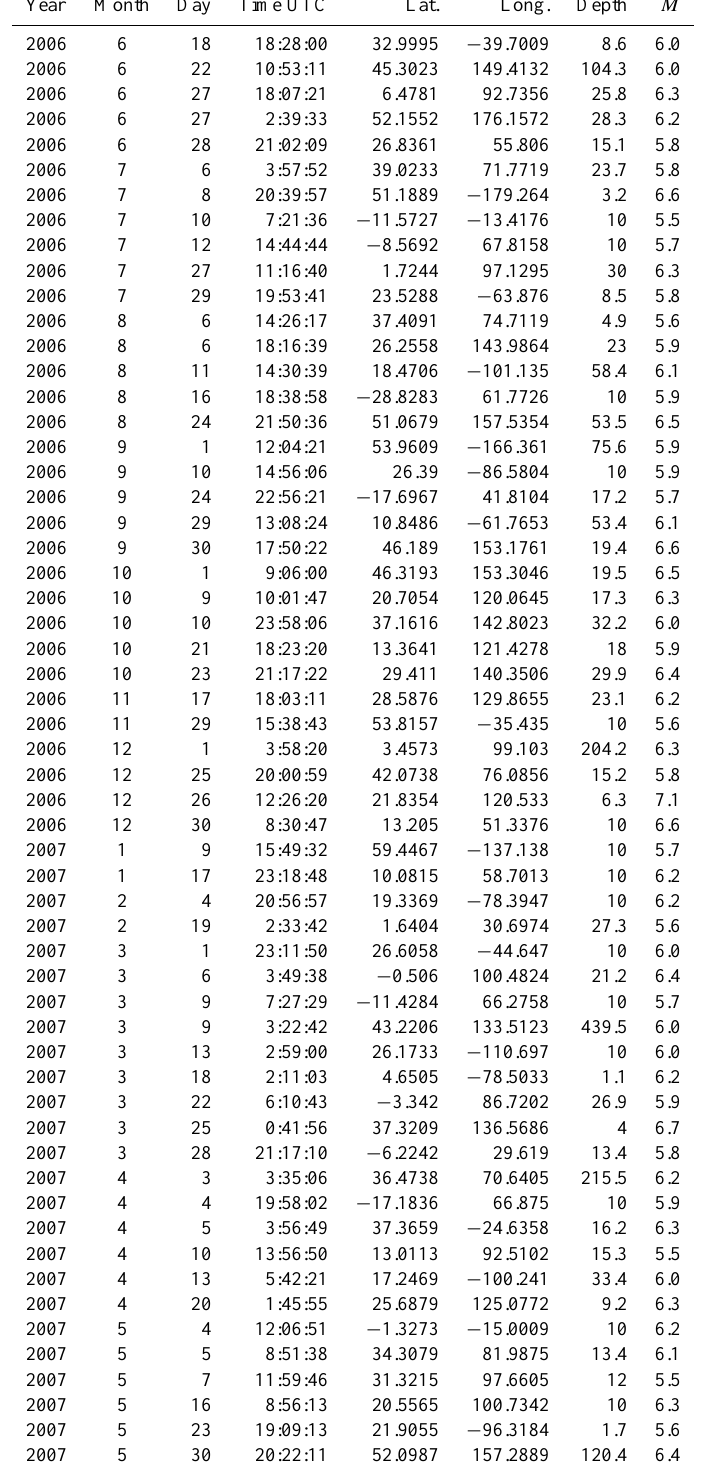
Table A1. List of 101 teleseismic EQs used in this